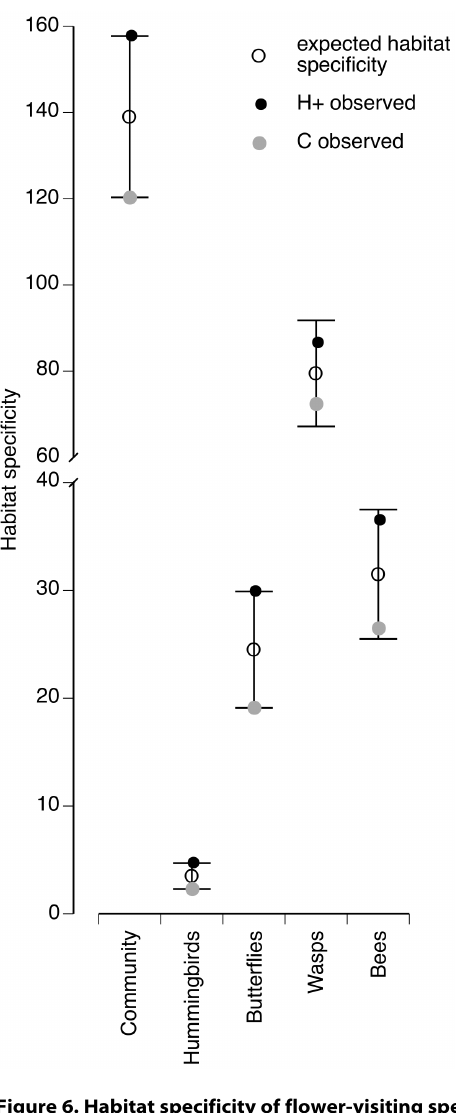
Figure 6. Habitat specificity of flower-visiting species in control and treatment coffee agroforests. Expected habitat specificity and 95% CI were obtained from 1000 sample-based randomizations. Observed habitat specificity is an area unweighted index obtained by dividing the number of species in each treatment by the harmonic mean of species abundances. Observed habitat specificity is shown as either significantly higher or lower than expected by chance if the observed value falls on the outer limits of the 95% CI of the null distribution.